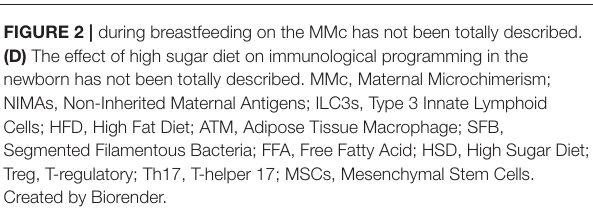
FIGURE 2 | during breastfeeding on the MMc has not been totally described. (D) The effect of high sugar diet on immunological programming in the newborn has not been totally described. MMc, Maternal Microchimerism; NIMAs, Non-Inherited Maternal Antigens; ILC3s, Type 3 Innate